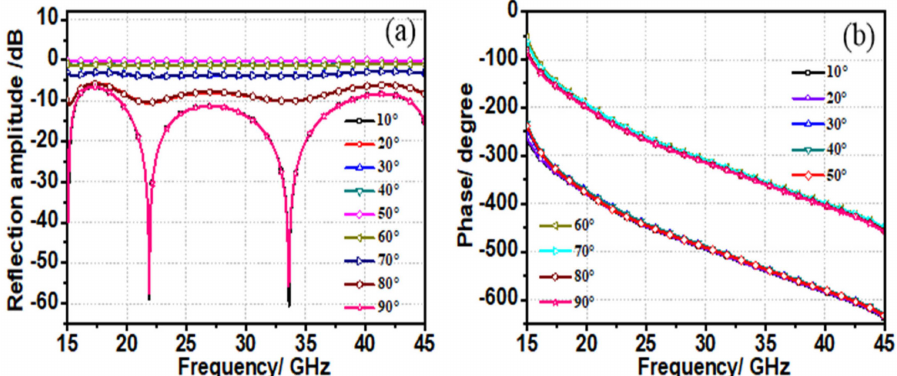
Figure 5. Rotation angle β increases from 10 ◦ to 90 ◦ , and a = 1.5 mm, ( a ) reflection amplitude and ( b ) phase of cross-polarization reflection coe ffi cient of the unit is obtained when the rotation angle β is di ff